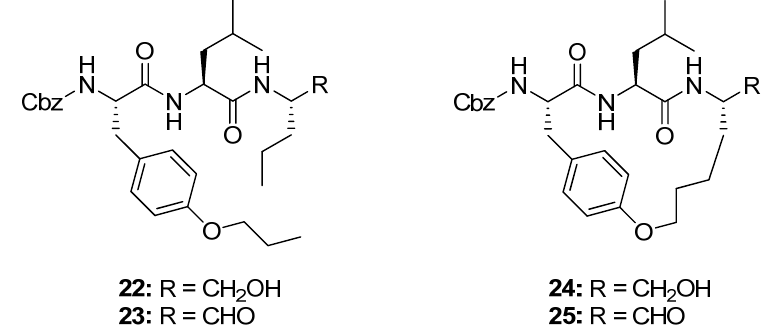
Figure 7. The macrocyclic cystein protease inhibitors 24 and 25 display greater selectivity for the cysteine protease o-CAPN2 than 22 and 23